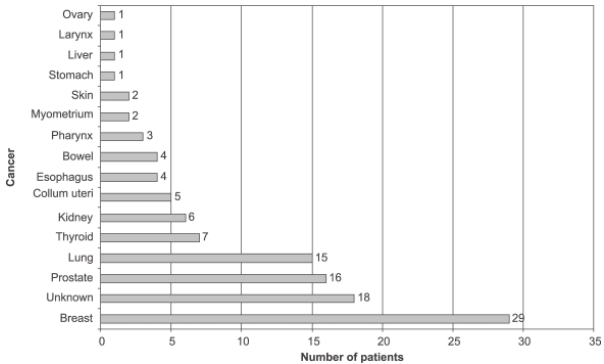
Figure 2- Distribution by primary tumor